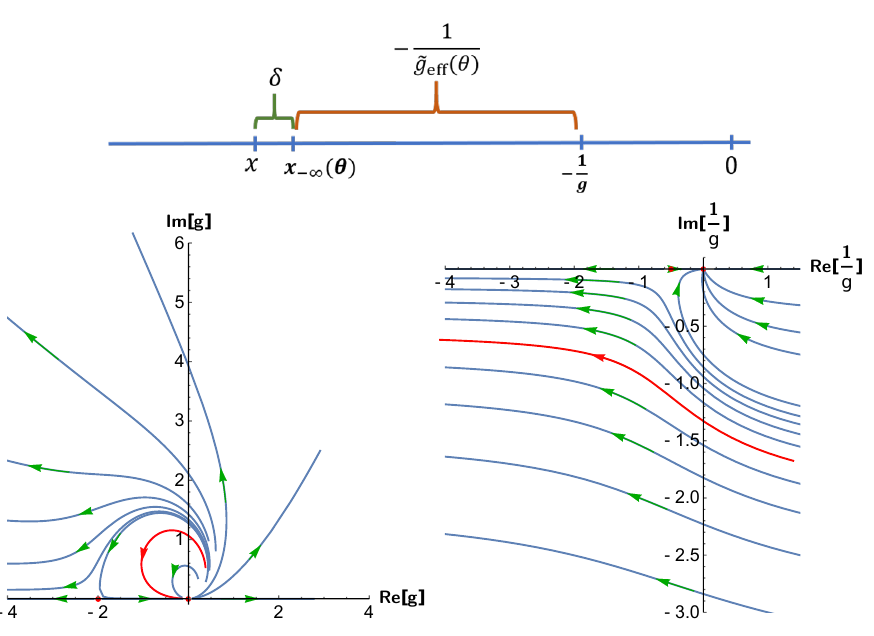
Figure 10 . In the top figure, g is assumed to be a some order 1 constant, independent of θ . x −∞ ( θ ) is farther away from − 1 as θ → ∞ . δ is the local variation around x g doesn’t have to be on the real axis. In the bottom figures, the red line is an example of g in this section, namely an example of circular RG